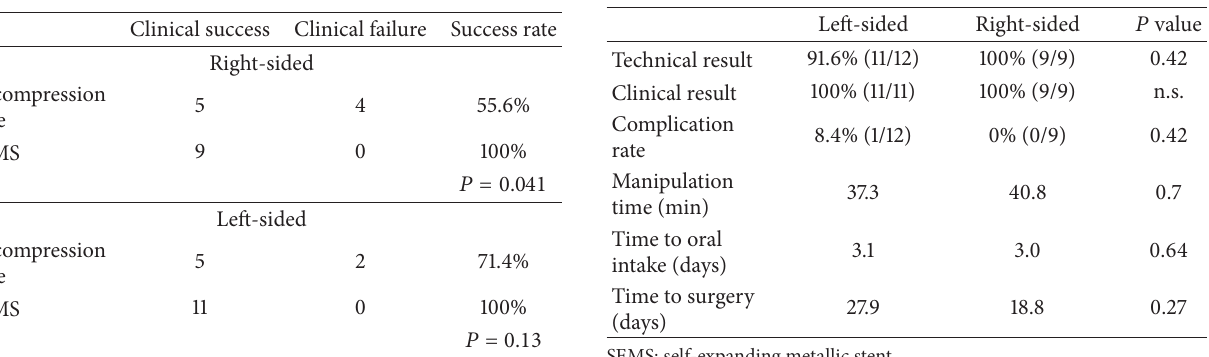
Table 2: Comparison of the clinical success rate between SEMS and decompression tube placement.